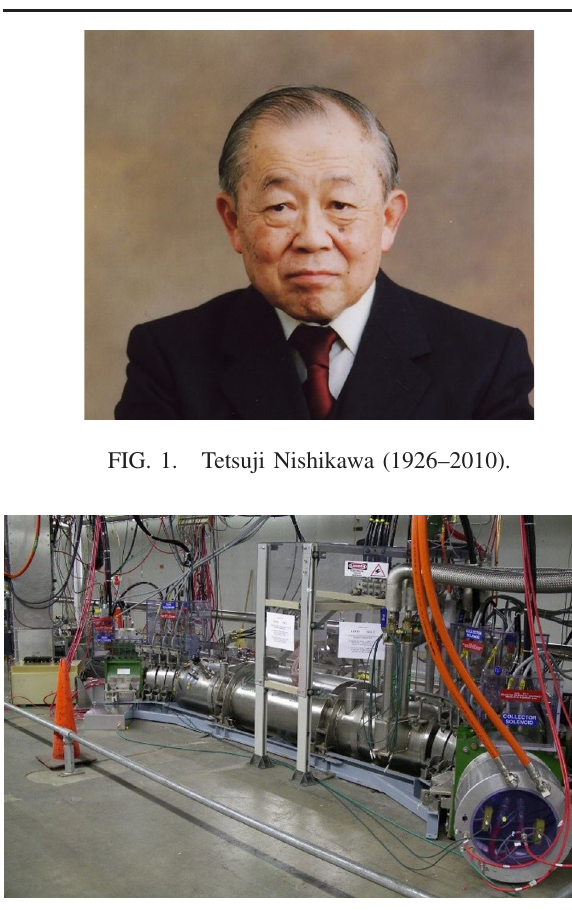
FIG. 2. Tevatron electron lens in the accelerator tunnel.